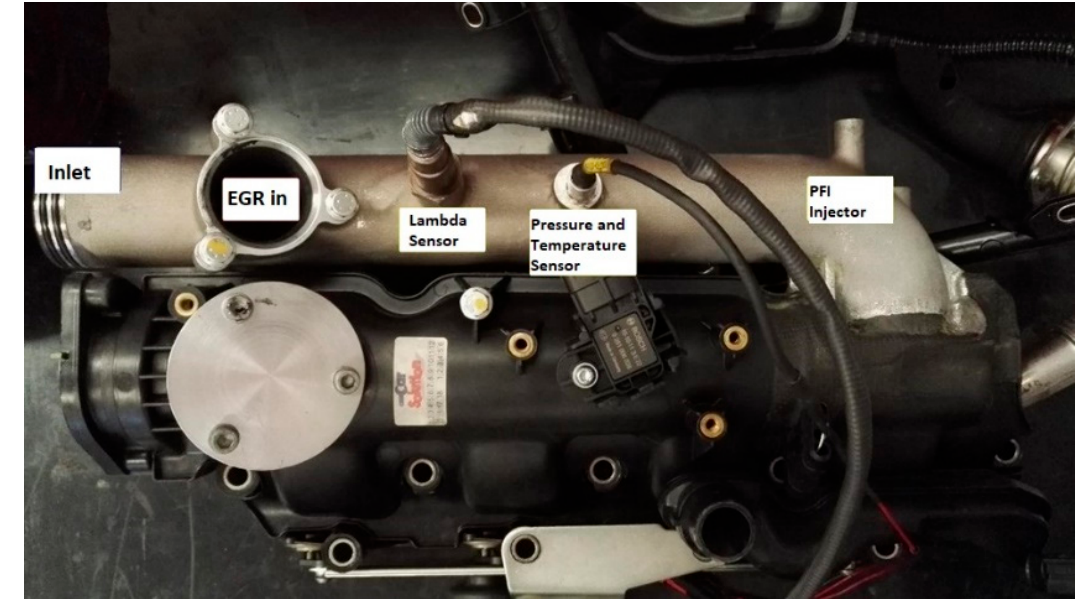
Figure 2. Picture of the modified intake manifold.